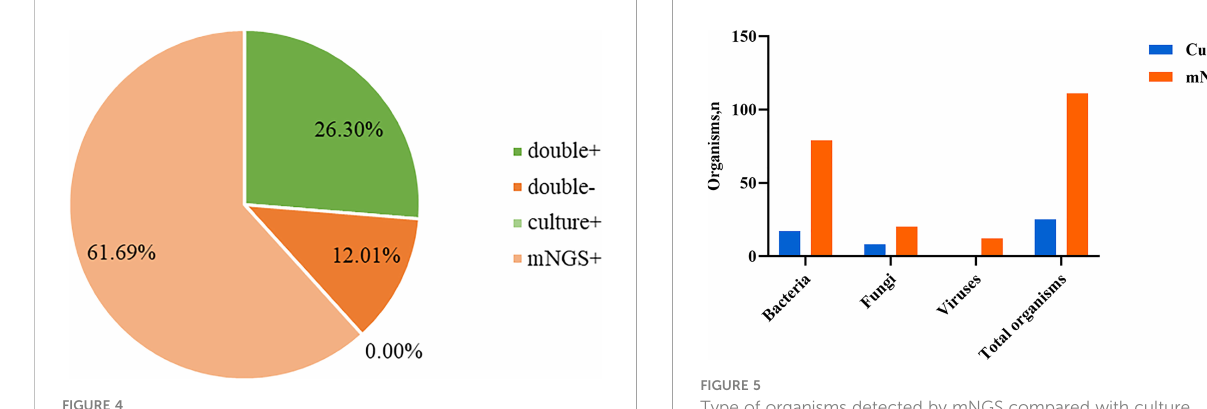
FIGURE 5 Type of organisms detected by mNGS compared with culture method. mNGS, metagenomic next-generation